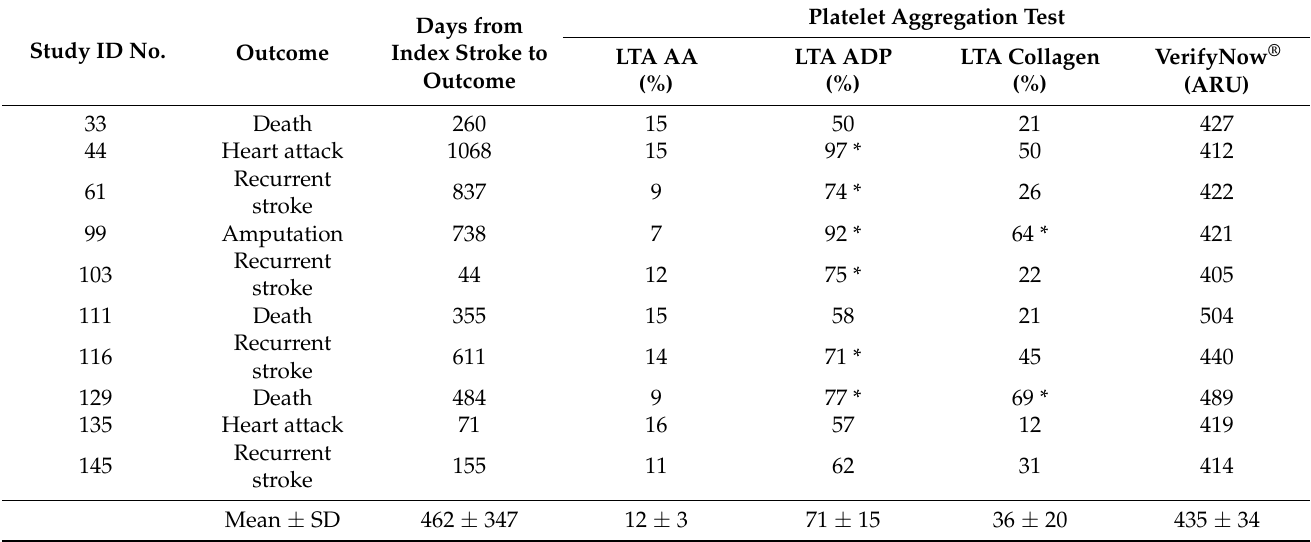
Figure 1. Comparison of different platelet aggregation tests in identifying “aspirin resistance”. Shaded area corresponds to cut-off for “aspirin resistance” for each test used. Table 3. Platelet aggregation test results among post-stroke patients with clinical outcomes (death, recurrent stroke, heart attack, and/or amputation), n =